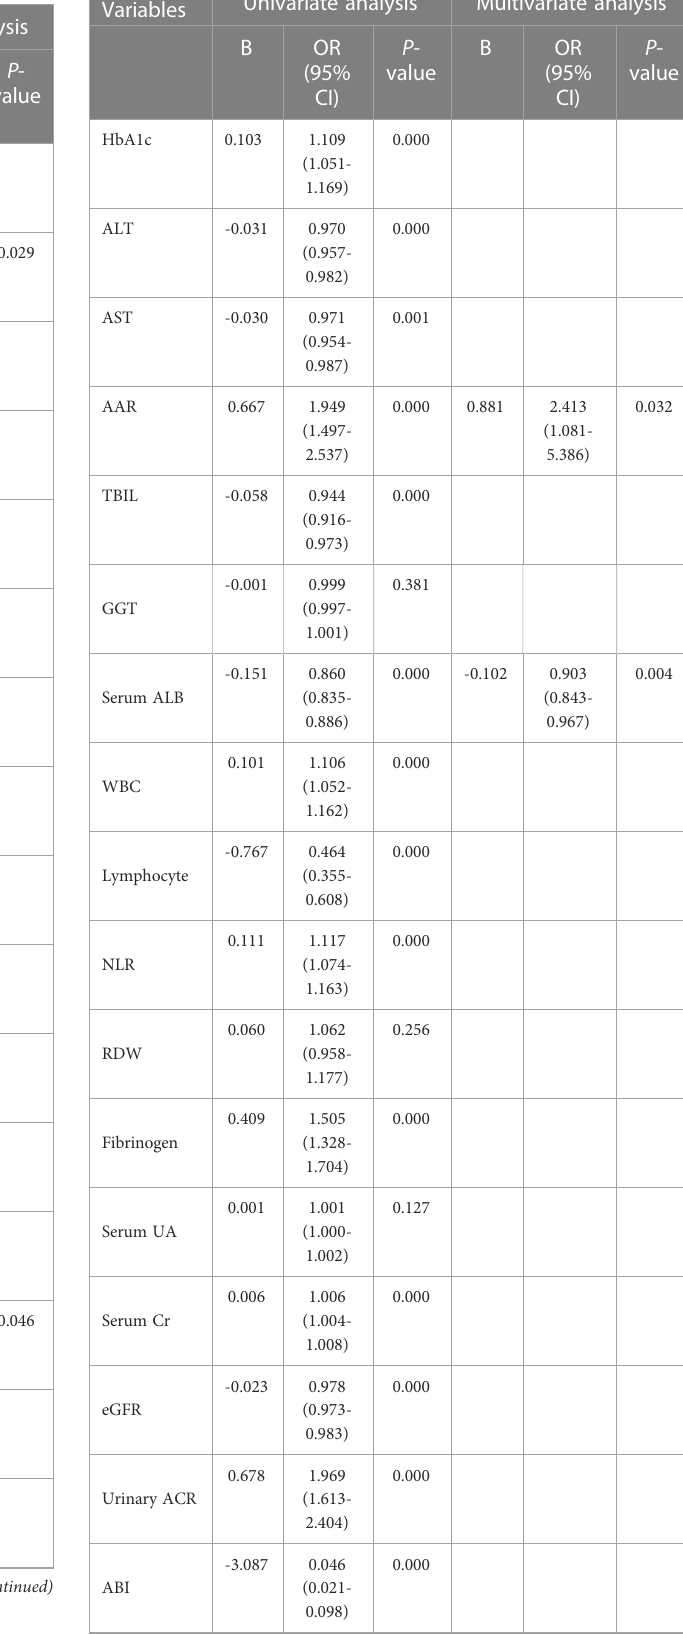
TABLE 3 Binary logistic regression analyses of variables contributing to DPN in patients with